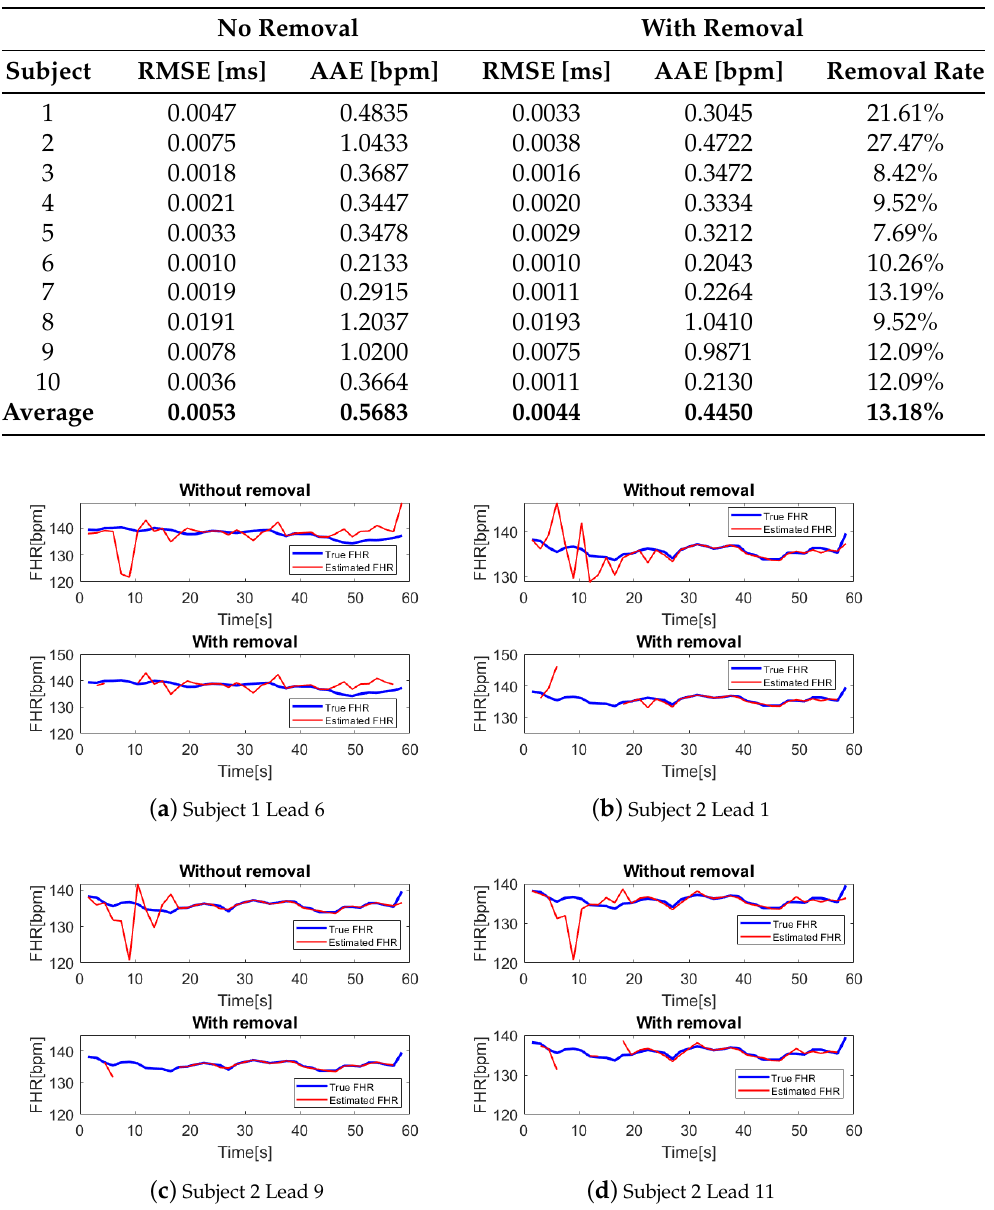
Table 2. Comparison of RMSE [ms] of FRRI, AAE [bpm] of FHR, and Removal Rate. The RMSE and AAE are all reduced by removing the detected low-quality segments, in the meantime, the removal rate is controlled within 15%.